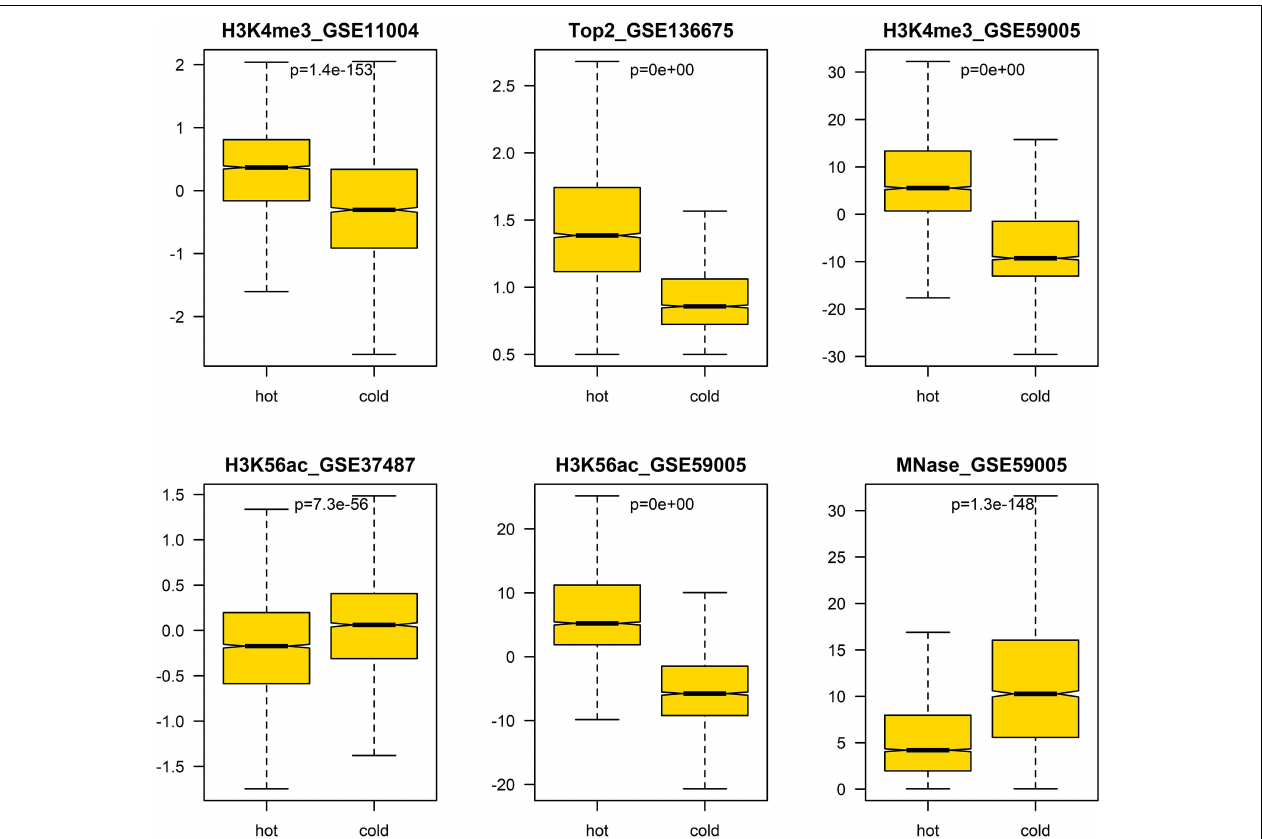
FIGURE 5 | Difference of epigenetic marks between hot/cold spots. The p -values were obtained via t